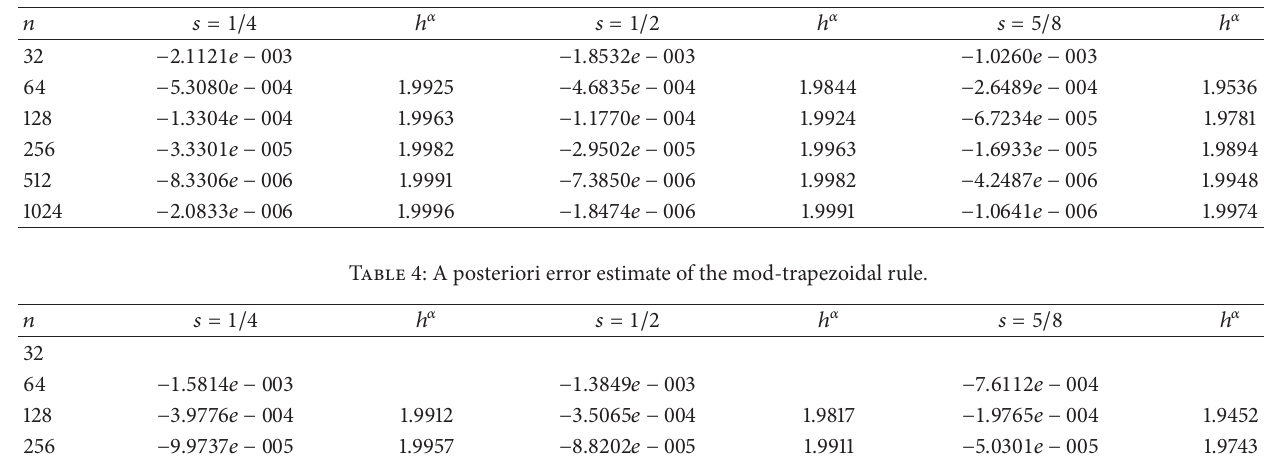
Table 3: Errors of the mod-trapezoidal rule.